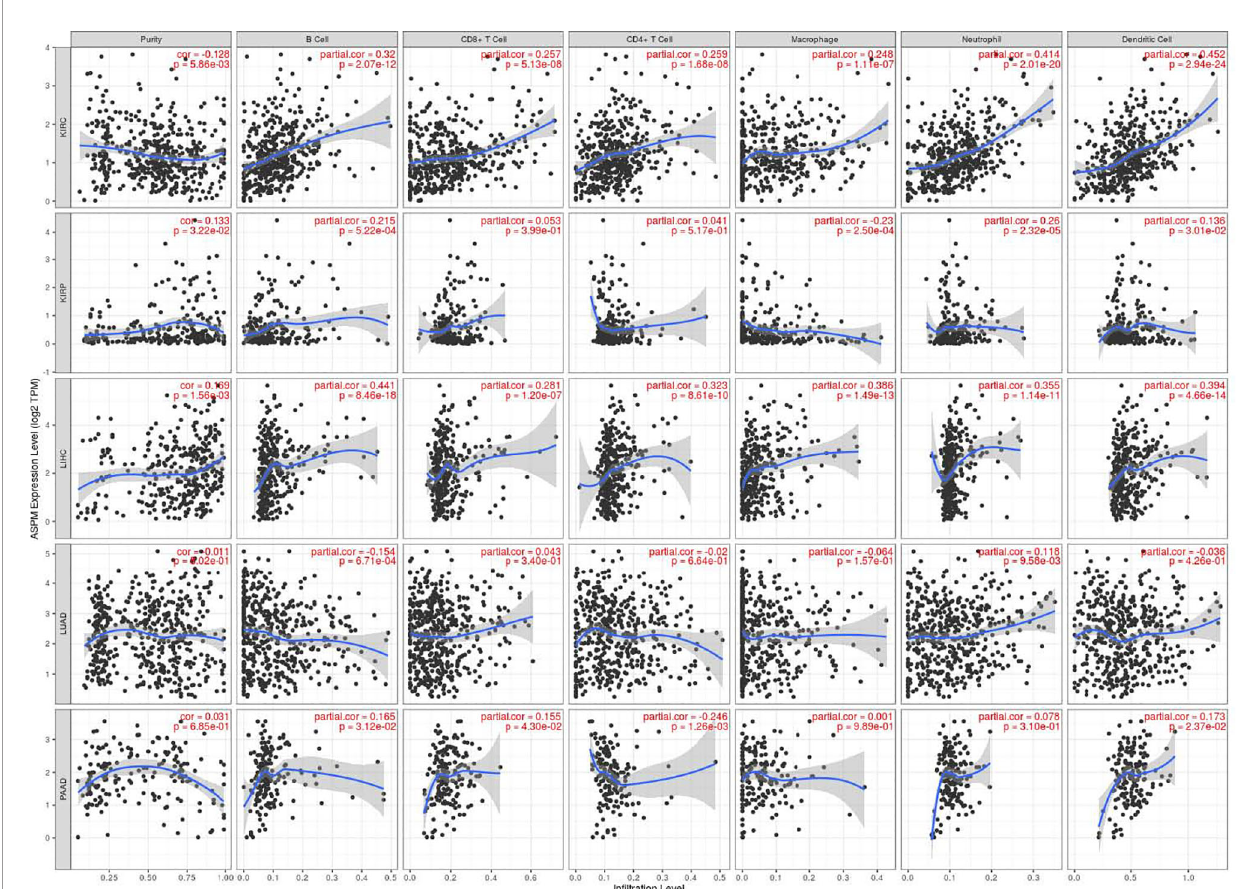
FIGURE 6 | Relationship between ASPM expression and tumor-in fi ltrating immune cells using TIMER database. ASPM expression is related to immune cell in fi ltration (B cells, CD8 + T cells, CD4 + T cells macrophages, neutrophils, and DCs) in KIRC, KIRP, LIHC, LUAD, PAAD, and BRCA using the TIMER database. cor: